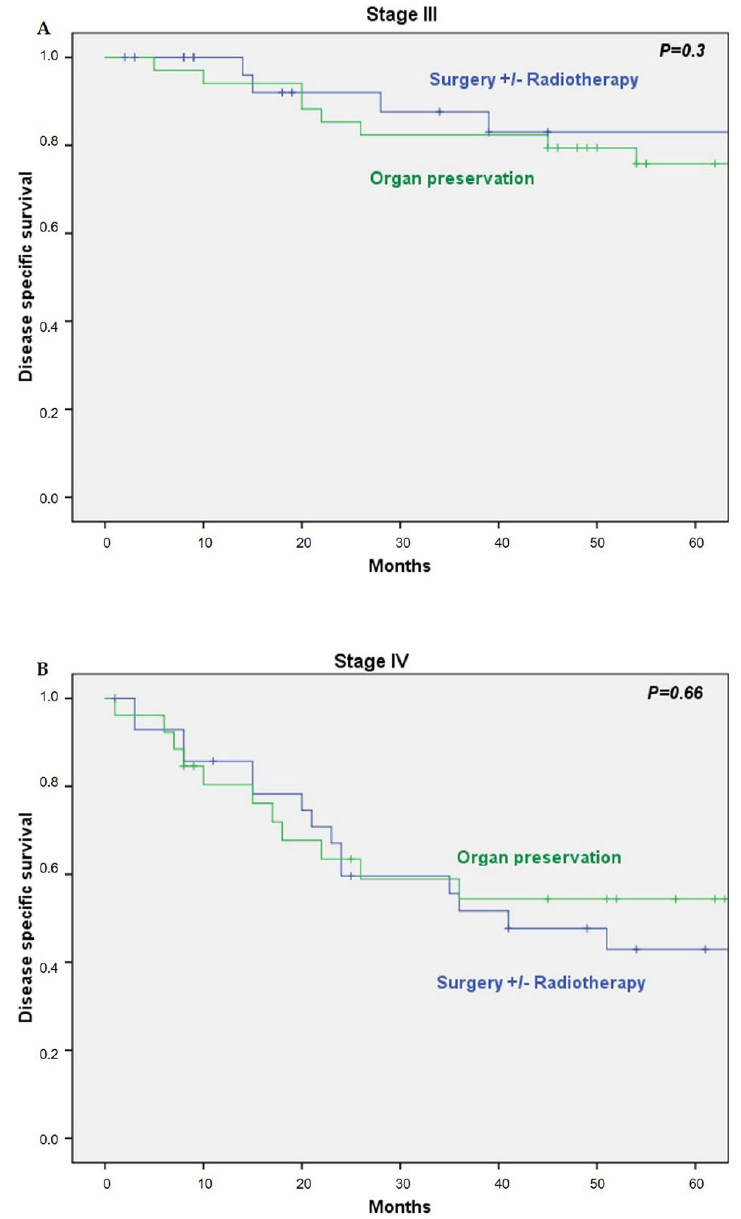
treatment in stage Figure 2. ( A ) Disease ‐ specific survival by treatment in stage III; ( B ) disease ‐ specific survival by treatment in stage IV.